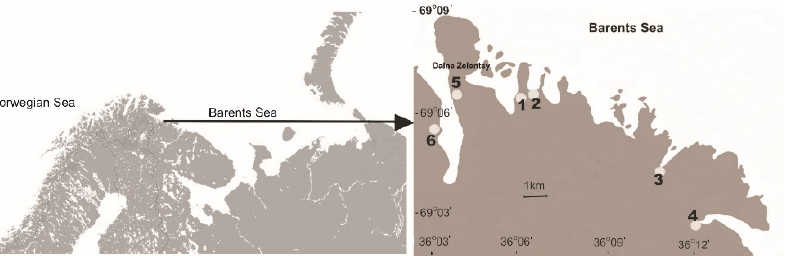
Figure 1. Map of study sites located within the bays at the Barents Sea: 1. Dalne-Zelenetskaya, 2. Plohye Chevry, 3. Medvezhya, 4. Parchniha and 5. and 6.